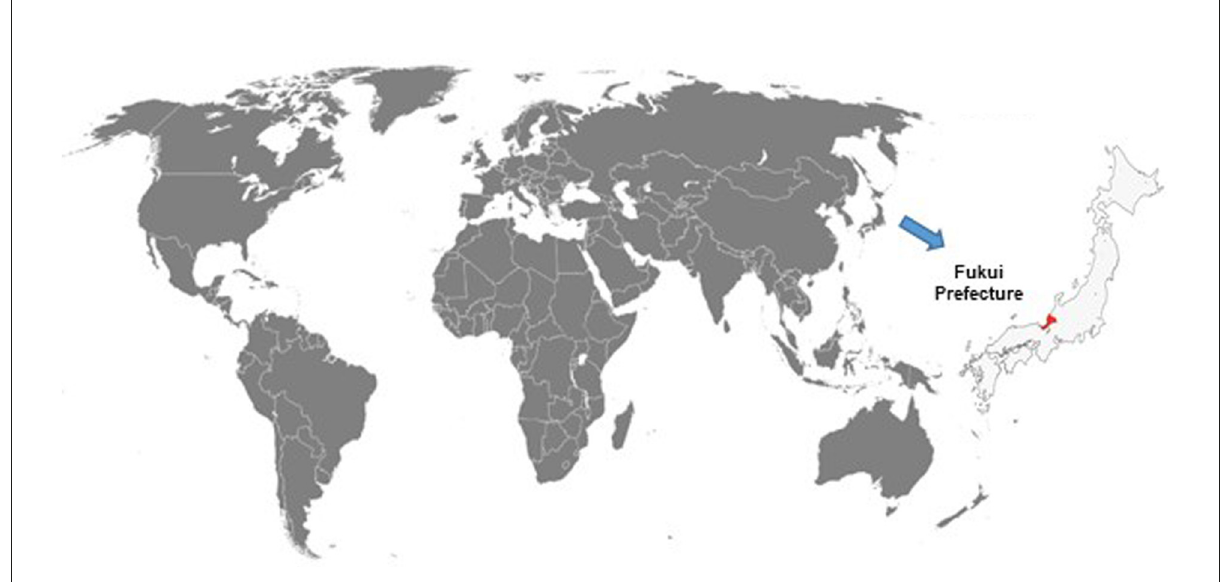
FIGURE1 Location of Fukui prefecture, Japan.